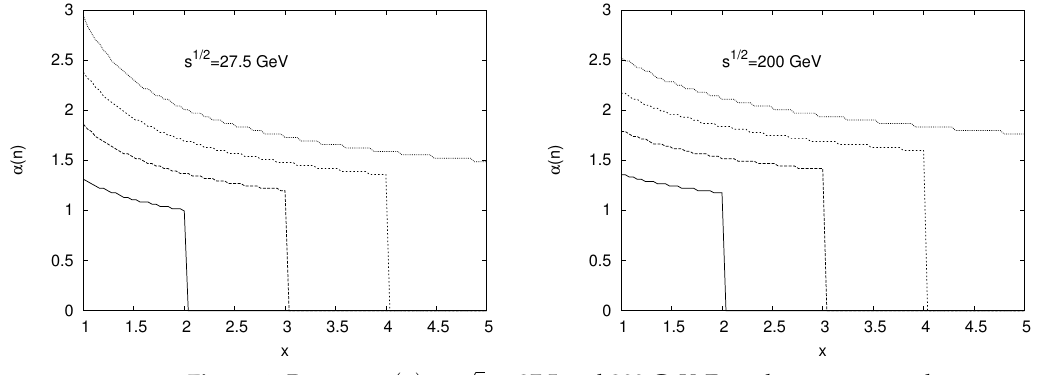
√ s = 27.5 and 200 GeV. From bottom to top, the curves correspond to Figure 4. Powers α n ( x ) at n = 2,3,4,5.